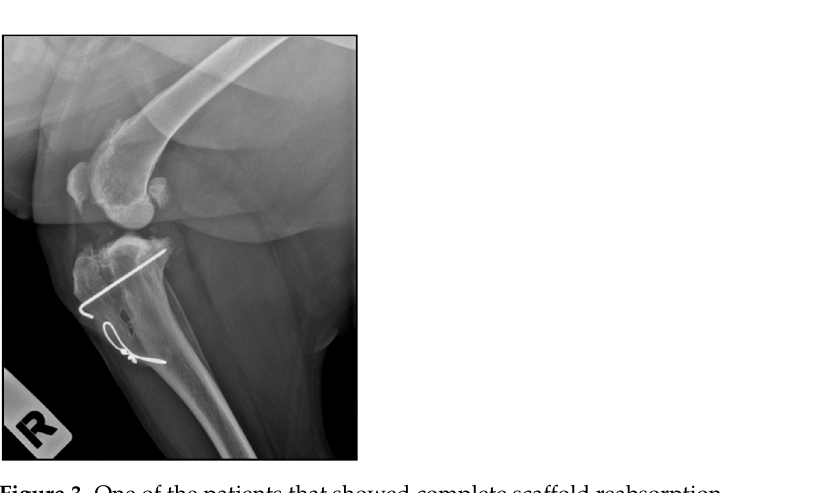
Figure 3. One of the patients that showed complete scaffold reabsorption.